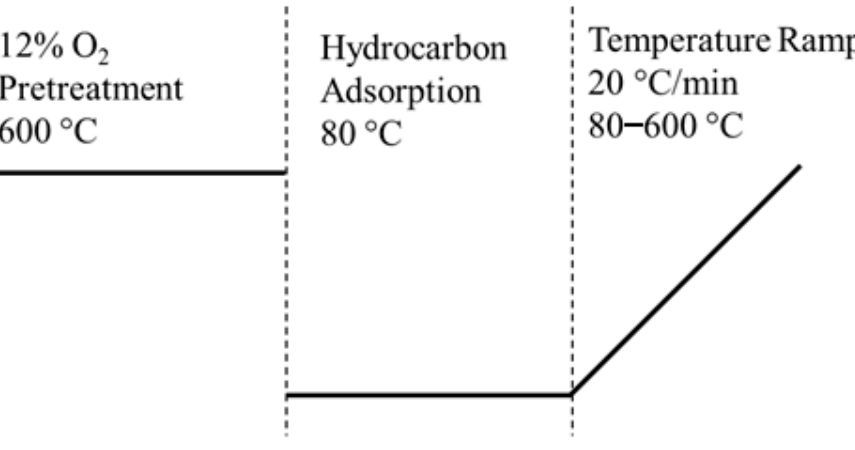
Figure 8. Adsorption-desorption protocol.